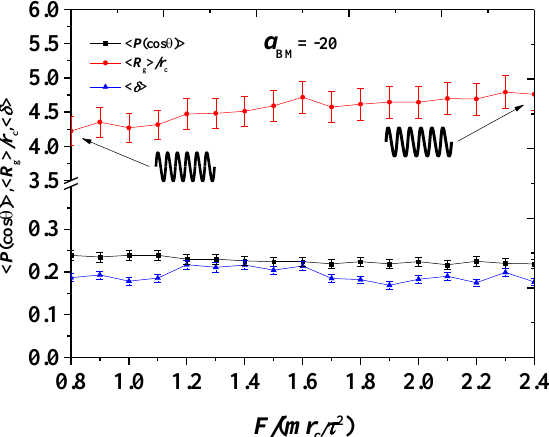
Figure 11. The system parameters as functions of the pulling forces in the strong adsorption cases of 𝑎 BM = −20 . The red dots and blue dots are the average radius of gyration factor δ for the bottlebrush polymers, respectively, while the black dots denote the order parameters P ( cos θ ) for the phospholipid membrane.